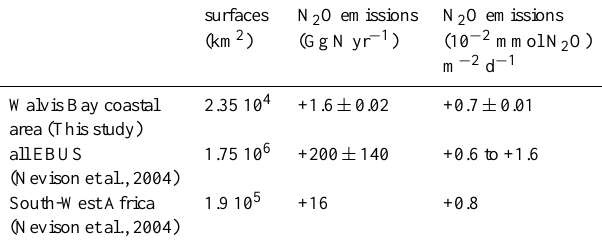
Table 4. N 2 O emissions to the atmosphere (GgNyr − 1